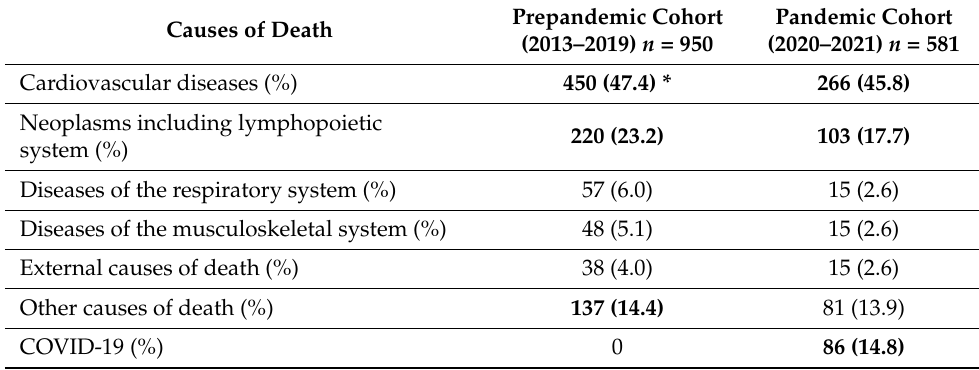
Table 2. Main causes of death in patients with rheumatic diseases in the prepandemic and pandemic